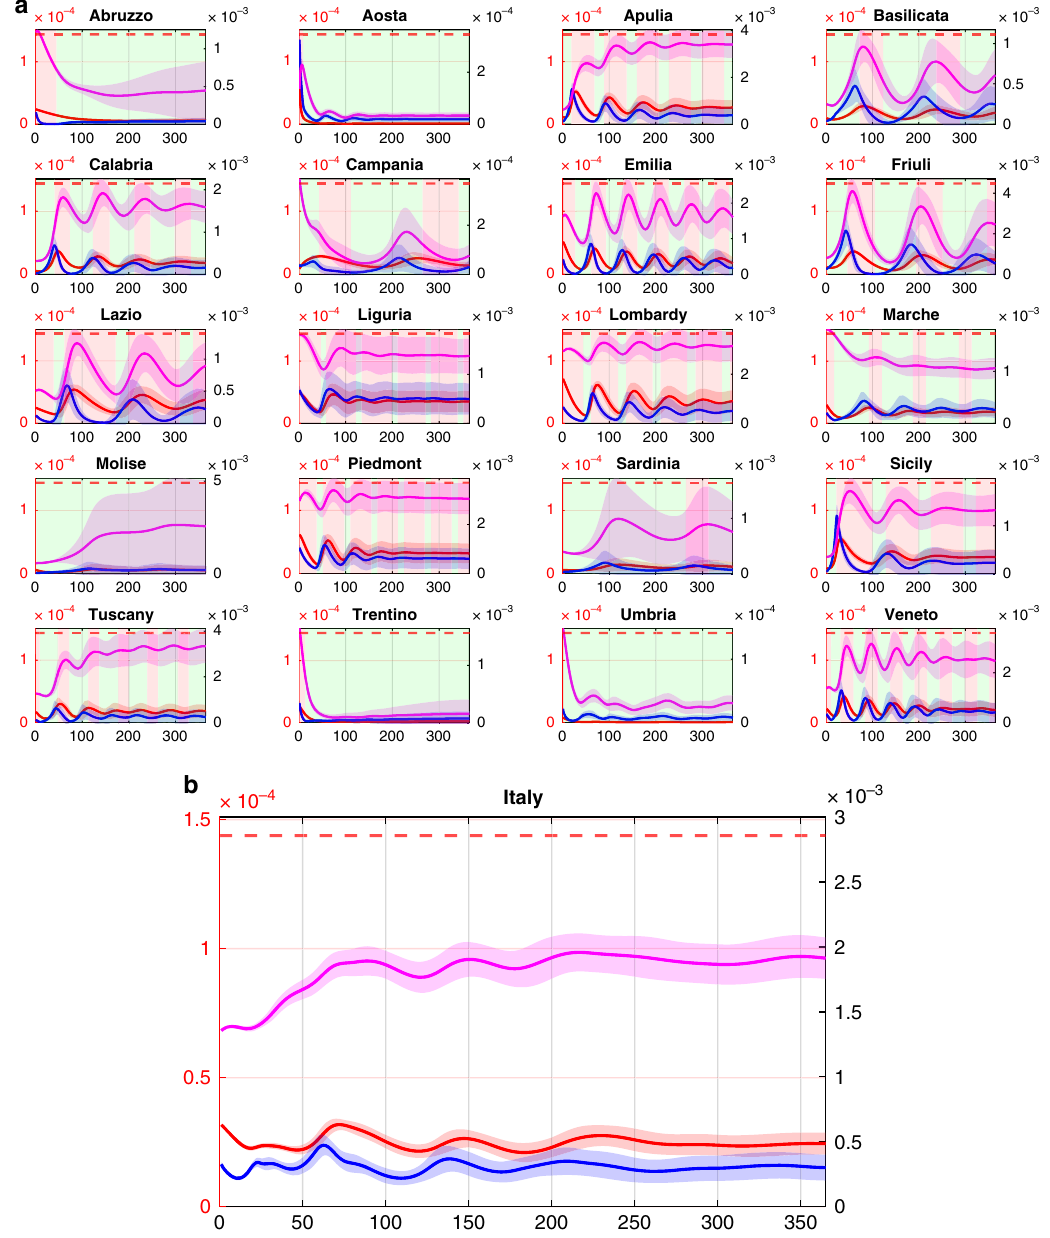
Fig. 4 Intermittent regional measures with increased COVID-19 testing capacity. a Each of the 20 panels shows in a double scale plot the evolution in the region named above the panel of the fraction in the population of infected (blue), quarantined (magenta) and hospitalized requiring ICUs (red) averaged over 10,000 simulations with parameters sampled using a Latin Hypercube technique (see Methods) around their nominal values set as those estimated in the last time window for each region as reported in Supplementary Table 4. Shaded bands correspond to twice the standard deviation. Dashed red lines represent the fraction of the population that can be treated in ICU ( T H i = N i ). Regions adopt lockdown measures in the time windows shaded in red while relax them in those shaded in green. During a regional lockdown, fl uxes in/out of the region are set to their minimum level. Regional COVID-19 testing capacities are assumed to be increased by a factor 2.5 (see Methods) with respect to their current values. b National evolution of the fraction of infected (blue), quarantined (magenta) and hospitalized requiring ICUs (red) obtained by summing those in each of the 20 regions adopting intermittent regional measures. All plots are shown with a double scale. The scale on the left vertical axis (in red) applies to the hospitalized requiring ICU and the ICU beds capacity threshold, while the right vertical axis (in black) applies to the infected and quarantined